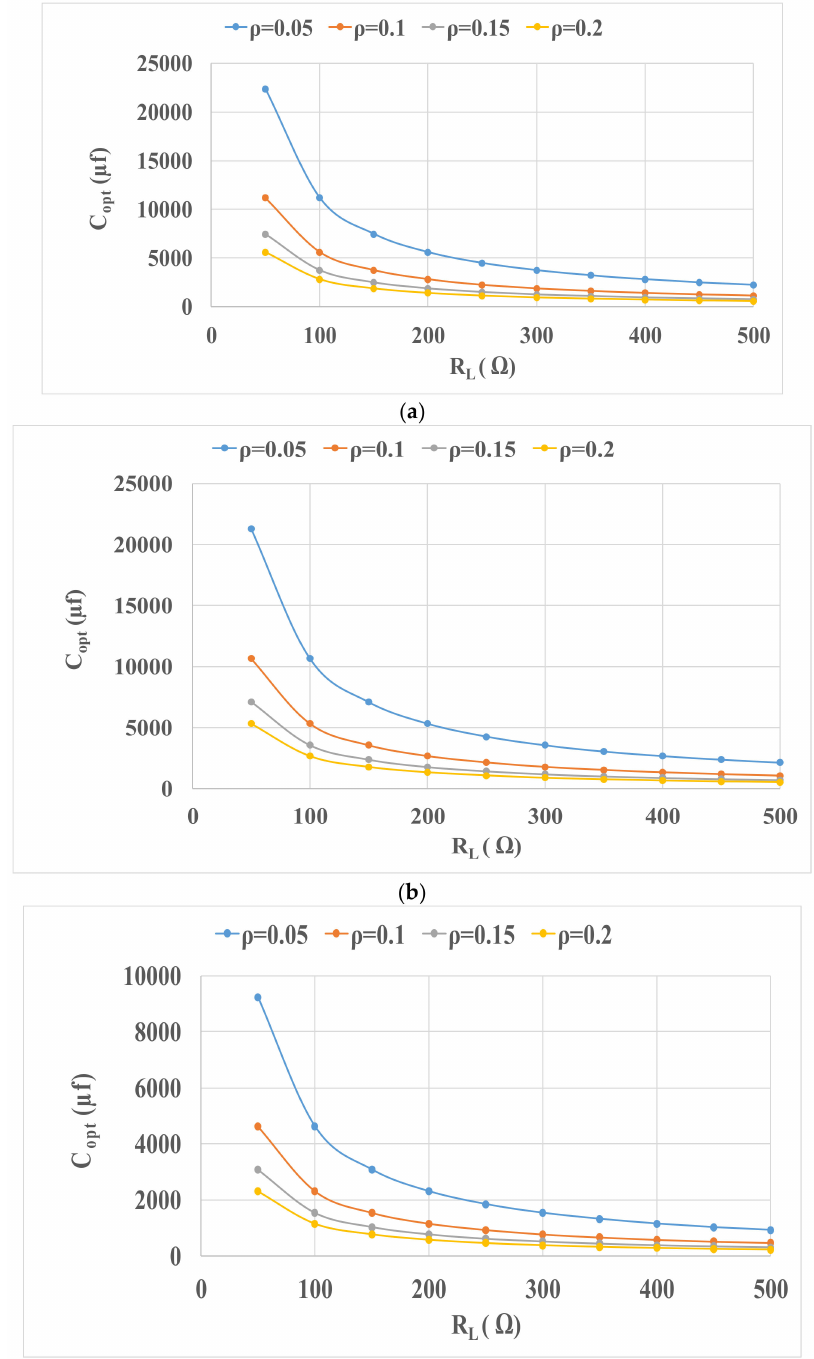
Figure 7. Variation of capacitance with resistance for di ff erent Value of ripple Voltage of capacitor ( a ) for C 3 , ( b ) for C 4 , and ( c ) for C